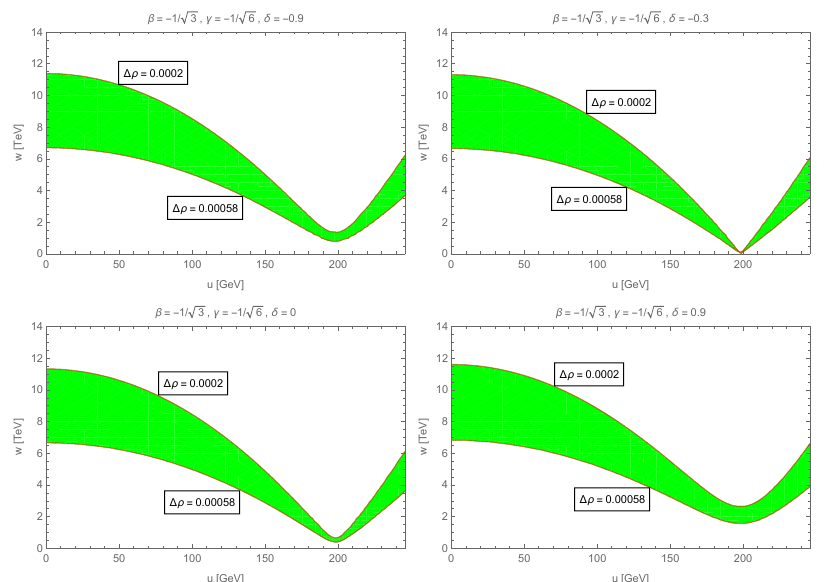
Figure 6 . The ( u, w ) regime that is bounded by the ρ parameter for ( β = 2 / √ 3, c = −√ 2 / √ 3) and w = 0 . 5Λ 1 / √ 6 , b = − − to δ = 0 . 9 , 0 . 3 , 0, and 0 . 9, − −